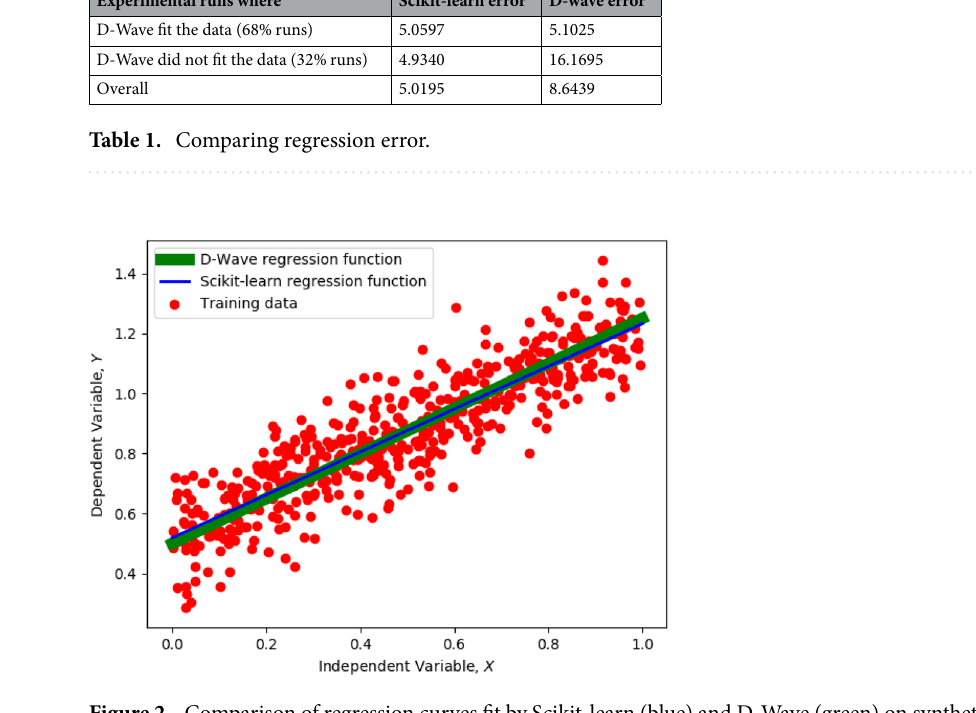
Figure 2. Comparison of regression curves fit by Scikit-learn (blue) and D-Wave (green) on synthetic data (red circles). X-axis shows the independent variable and Y-axis shows the dependent variable. Both curves closely resemble each other. We use a thicker green line and a thinner blue line for D-Wave and Scikit-learn respectively for the sake of clarity only—the two lines are very close to each